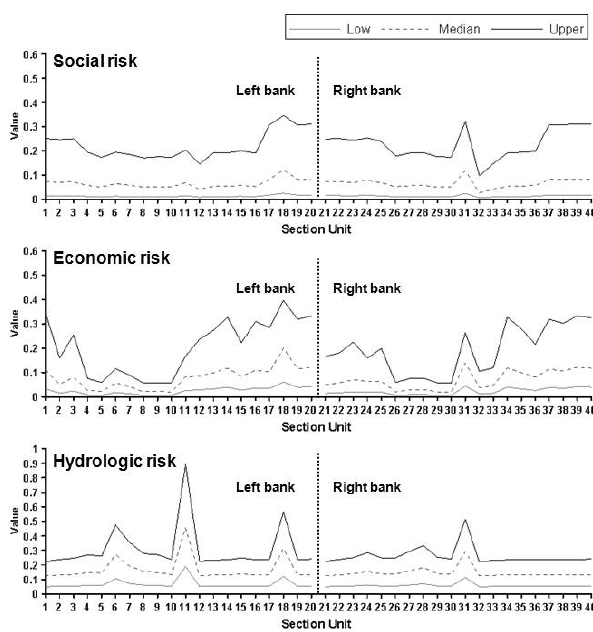
Fig. 8. Normalized fuzzy matrix.